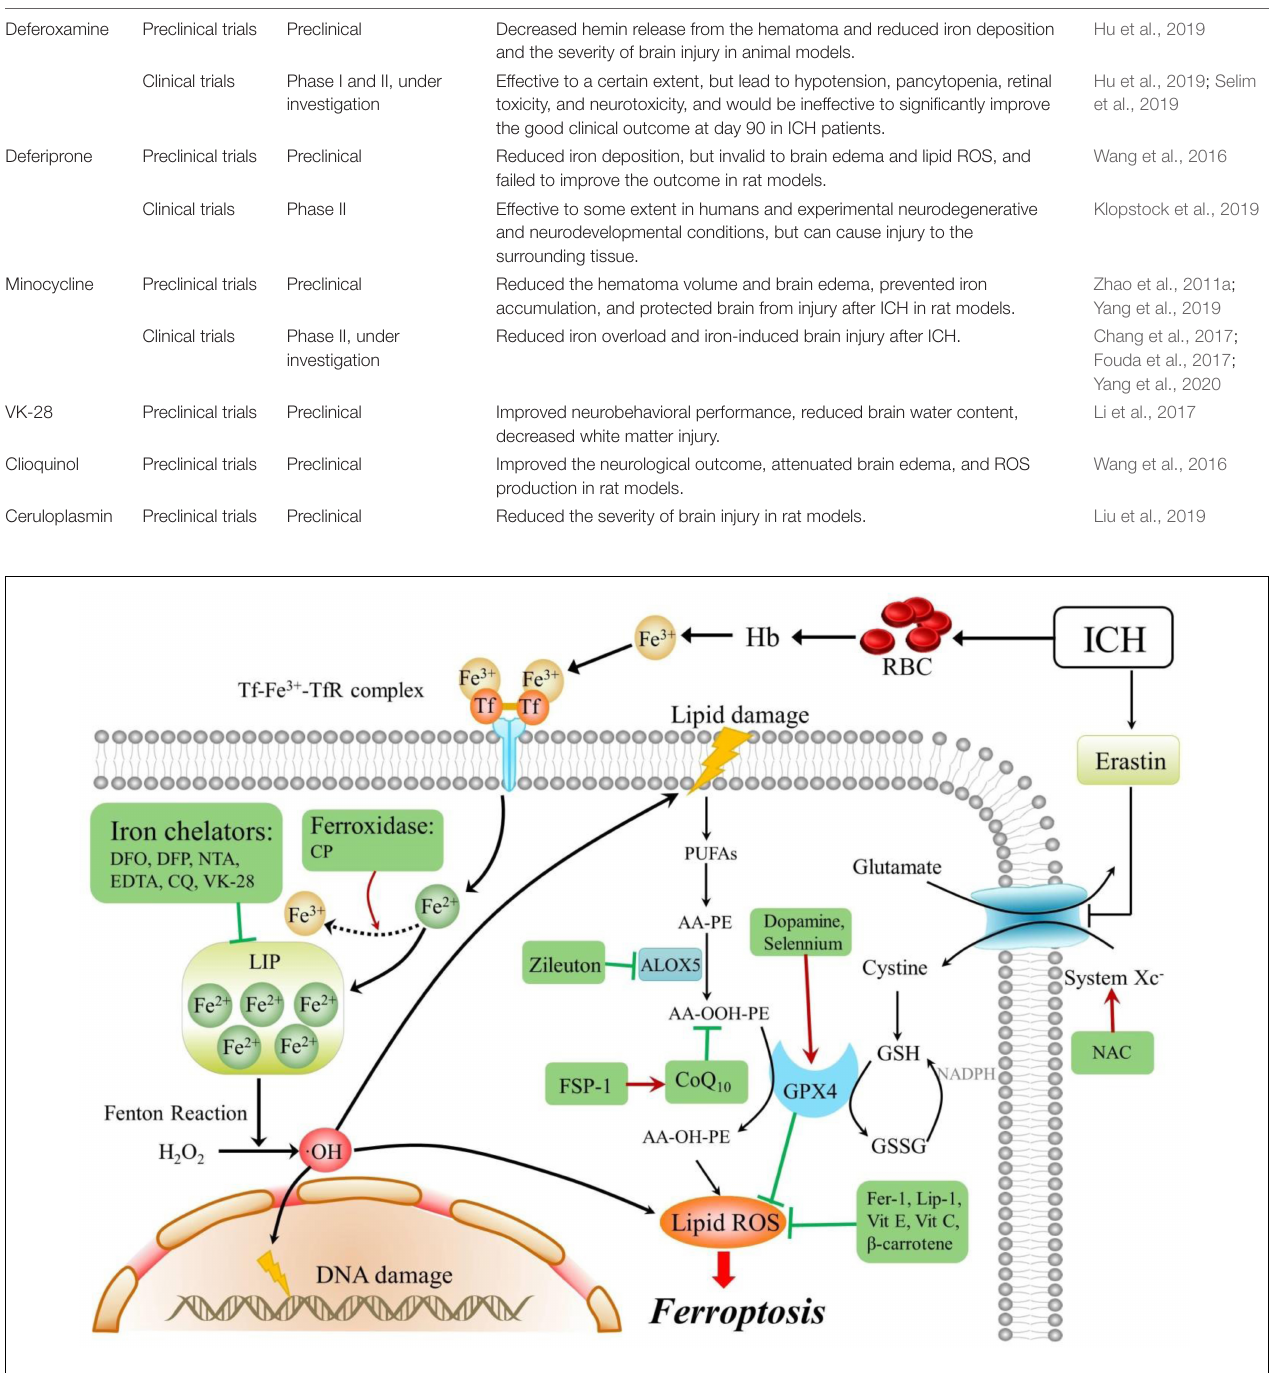
FIGURE 1 | Mechanisms and modulators of ferroptosis after ICH. Arrows indicate promotion, blunt- ended lines indicate inhibition, and the drugs in a green box are ferroptosis inhibitors. ICH, intracerebral hemorrhage; RBC, red blood cell; Tf, transferrin; TfR, transferrin receptor; AA, arachidonic acid; PE, phosphatidylethanolamine; PUFAs, plasma membrane polyunsaturated fatty acids; CoQ 10, coenzyme Q10; DFO, deferoxamine; DFP, deferiprone; NTA, nitrilotriacetic acid; EDTA, ethylenediaminetetraacetic acid; CQ, clioquinol; CP, ceruloplasmin; H2O2, hydrogen peroxide; OH, hydroxyl radical; Fer-1, ferrostatin-1; GPX4, glutathione peroxidase 4; Vit E, vitamin E; Vit C, vitamin C; FSP-1, ferroptosis suppressor protein 1; GSH, glutathione; GSSG, oxidized glutathione; Hb, hemoglobin; Lip-1, liproxstatin-1; NAC, N-acetylcysteine; LOX, lipoxygenase; and ROS, reactive oxygen